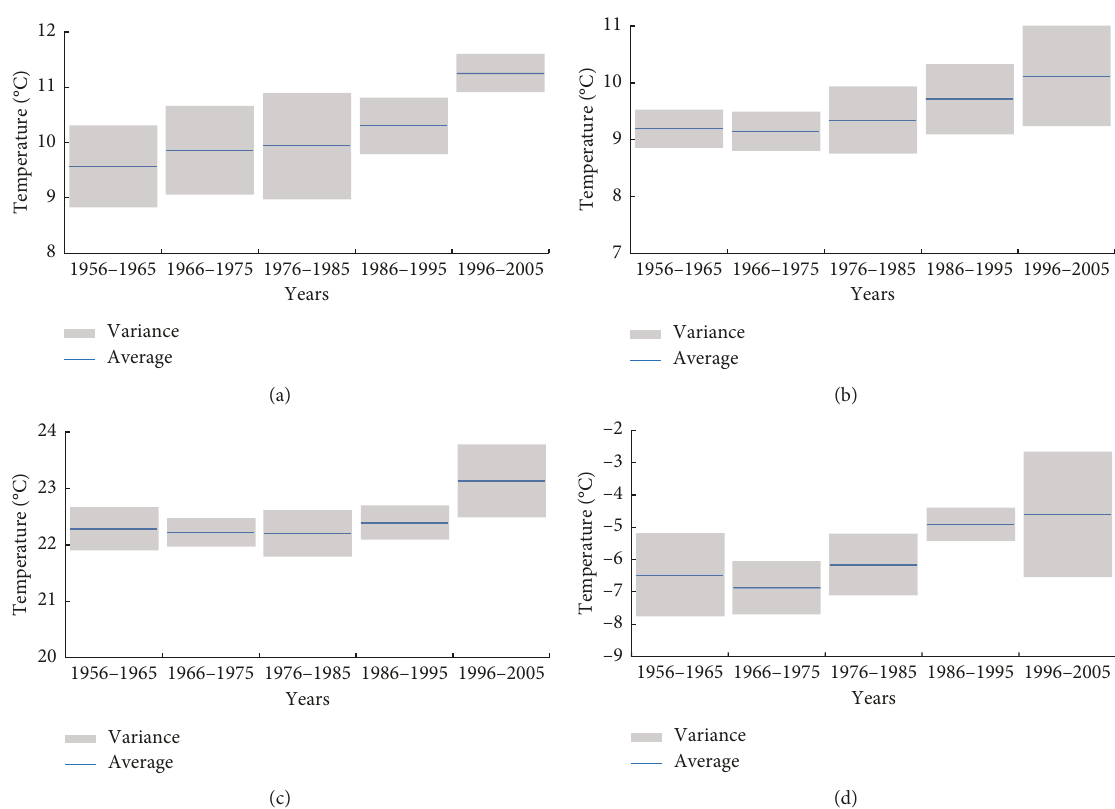
Figure 5: Decadal mean and variance of the regional average temperature for each season: (a) spring; (b) autumn; (c) summer; (d)